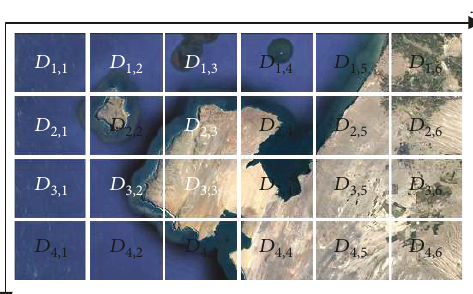
Figure 4: Illustration of the number of SURF features in each block.